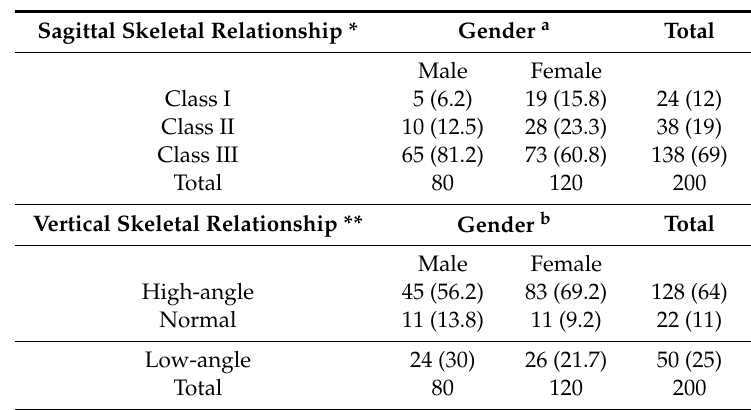
Table 3. Gender distribution of sagittal and vertical skeletal relationships.